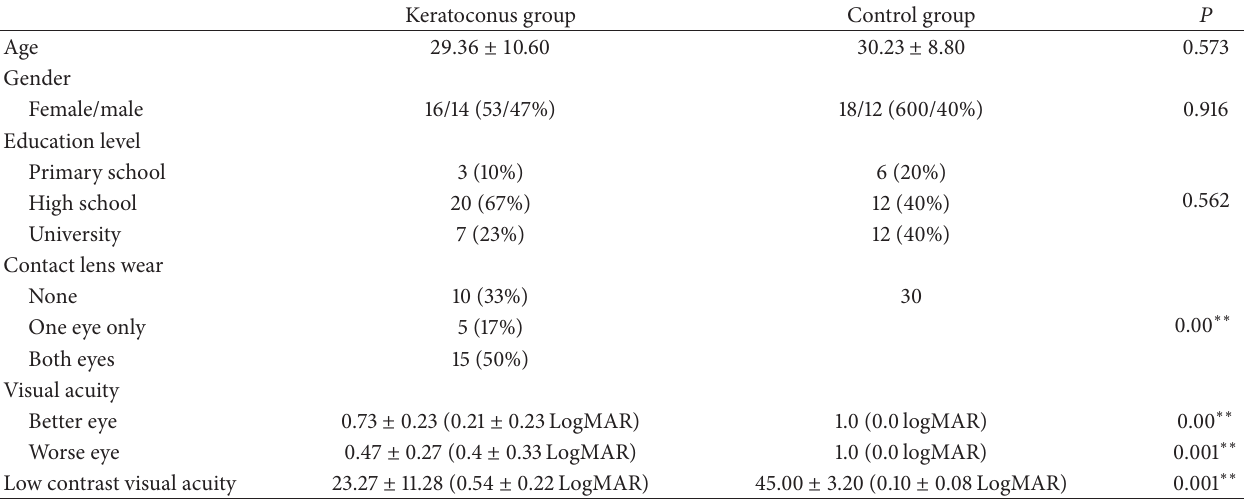
Table 1: Demographic characteristics of the patients (age, gender, education, and contact lens use and high contrast (Snellen) and low contrast visual acuity (letters)) according to the groups ( ∗ 𝑃 < 0.05 ; ∗∗ 𝑃 < 0.001 ).